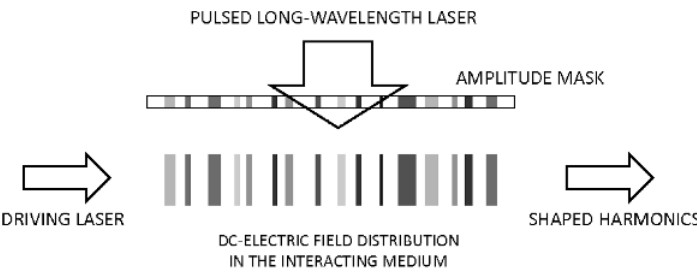
Fig. 1. Schematic illustration of a static-electric-field distributed along the driving pulse propagation direction. A pulsed long-wavelength laser - such as e.g. a pulsed terahertz or CO laser, is sent through an amplitude mask whose amplitude pattern generates the desired field distribution. Both the long-wavelength laser and the driving laser are linearly polarized in the direction orthogonal to the plane of the